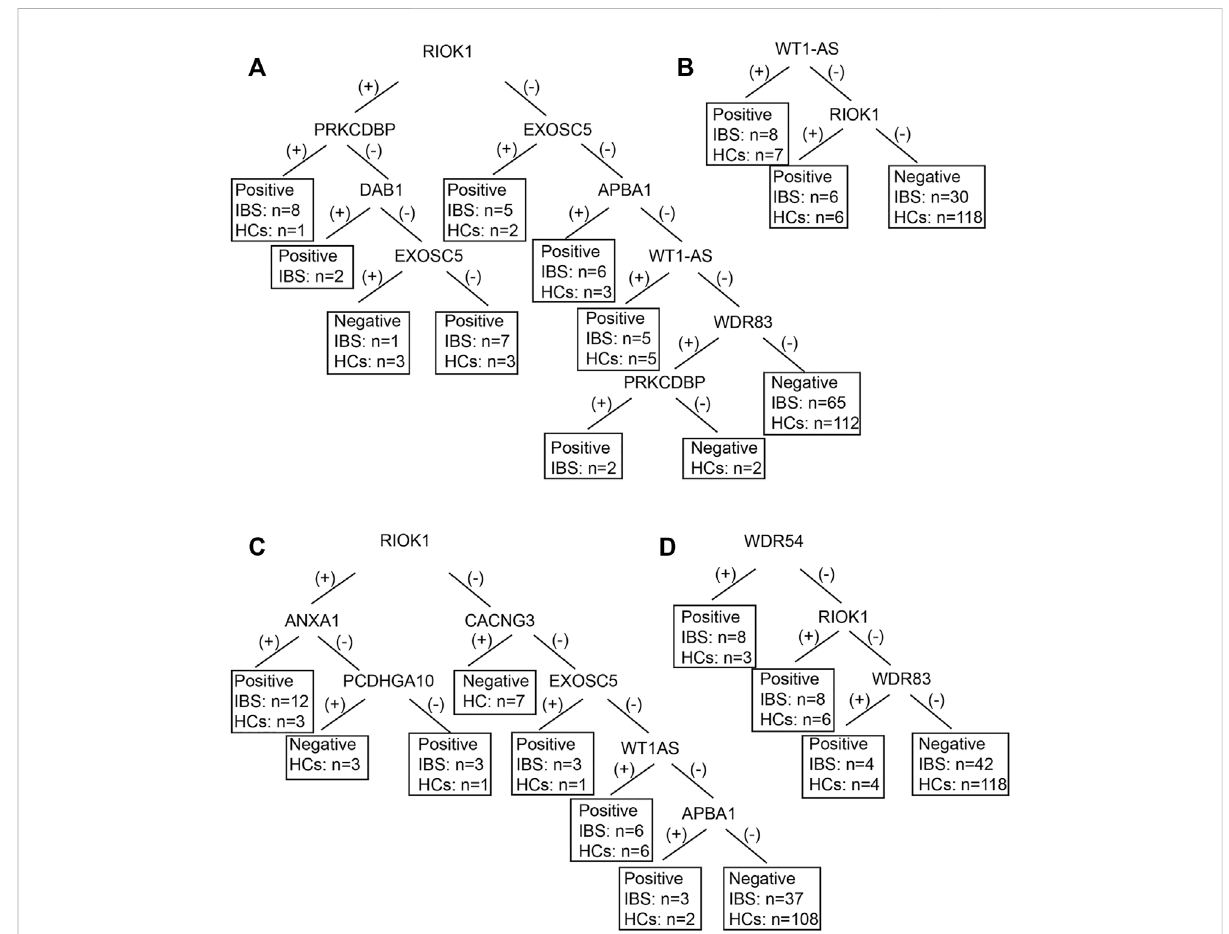
FIGURE 3 The decision tree models of IgG between IBS subgroup patients and HCs. Negative refers to healthy control can be diagnosed. (A) IBS patients with persistent symptoms and HCs. Positive refers to IBS with persistent symptoms can be diagnosed. (B) IBS patients with severe abdominal pain/ discomfortandHCs.PositivereferstoIBSwithsevereabdominalpain/discomfortcanbediagnosed. (C) IBSpatientswithseveresymptomsandHCs. Positive refers to IBS with severe symptoms can be diagnosed. (D) IBS patients with severe anxiety and HCs. Positive refers to IBS with severe anxiety can be